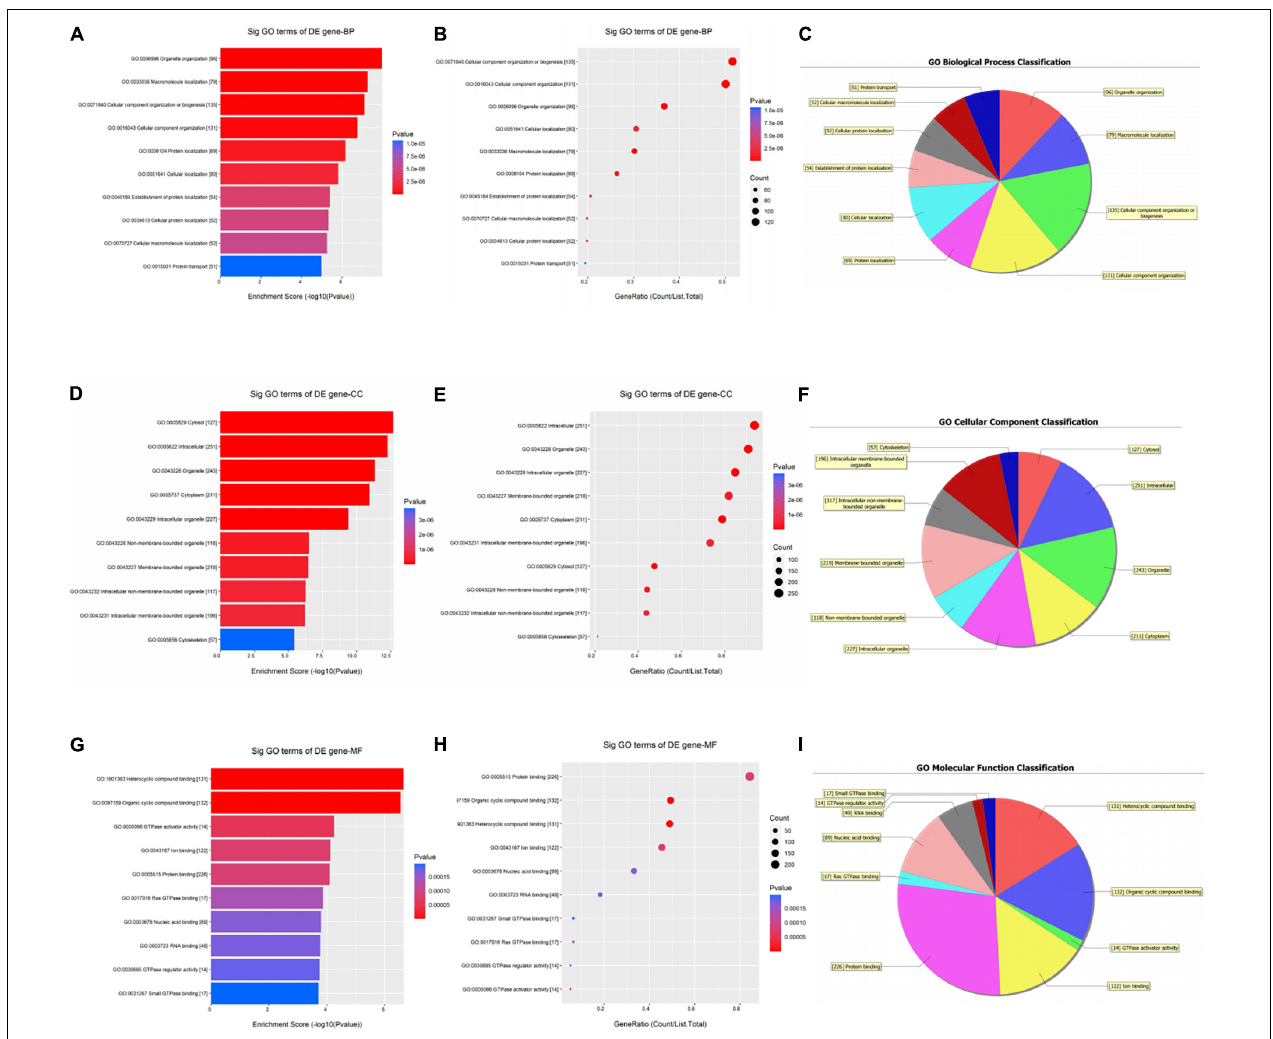
FIGURE 3 | Gene ontology (GO) enrichment analysis of downregulated circRNAs. For bubble plot, the y-axis shows the enriched terms in three GO categories and the x-axis shows the Enrichment Score [ − log10( P -value)] or GeneRatio (Count/List. Total): (A,B) biological process, (D,E) cellular component, (G,H) molecular function. Pie chart shows the distribution of significantly GO terms: (C) biological process, (F) cellular component, (I) molecular